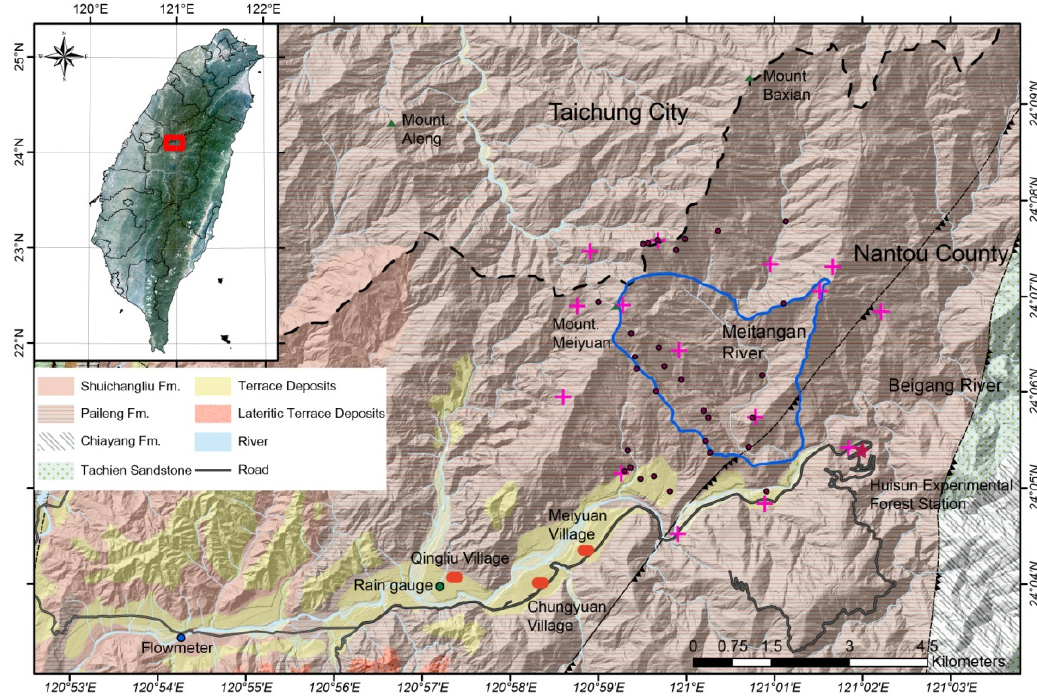
Figure 1. Geological map and geographical position of the study area. The blue line shows the range of orthoimage and digital terrain model (DTM) data generated in this research. There is a rain gauge (green point) and a flowmeter (blue point) in the adjacent area. Multiple residential villages are located downstream of the study area. The study area is shown in red square within the upper-left index map. Three data sets derived from aerial photogrammetry in this research used the same 15 ground control points shown as pink cross marks. The UAV dataset used the 30 ground control points shown as dark brown dots.